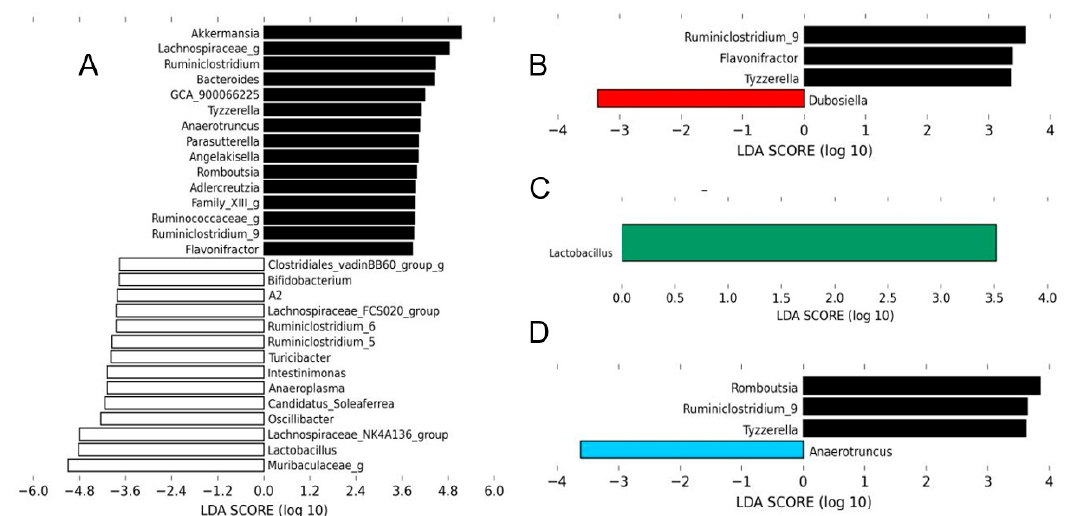
Figure 4. Each HMH treatment induced changes in the gut microbiota at the genus level. The linear discriminant analysis (LDA) effect size was calculated in order to explore the taxa within genus levels that more strongly discriminated between the gut microbiota of mice fed with ( A ) chow (white) and high-fat high-sucrose (HFHS), ( B ) HFHS and HMH1 (red), ( C ) HFHS and HMH2 (green), and ( D ) HFHS and HMH3 (blue). The statistical significance of differentially abundant bacteria between the two distinct biological conditions was measured using linear discriminant analysis effect size (LEfSe). Black bars represent HFHS.